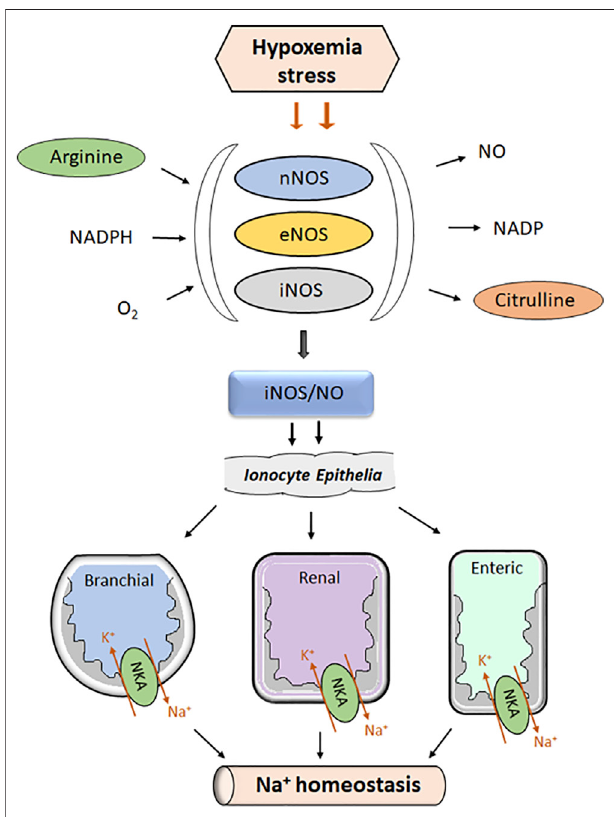
FIGURE 2 | Chart showing the impact of hypoxemia stress on the activation of the iNOS/NO system in the ionocytes of fi sh. In fi shes, varied isoforms of nitric oxide synthases: endothelial (eNOS), neuronal (nNOS), and inducible (iNOS) are involved in the production of NO from L-arginine in thepresenceofNADPHandO 2 .Uponinductionofhypoxemiastressinanair- breathing fi sh ( A. testudineus ), activation of the iNOS/NO system occurs in branchial ionocytes. This leads to the differential regulation of NKA that ultimately contributes to the recovery of systemic Na + balance.